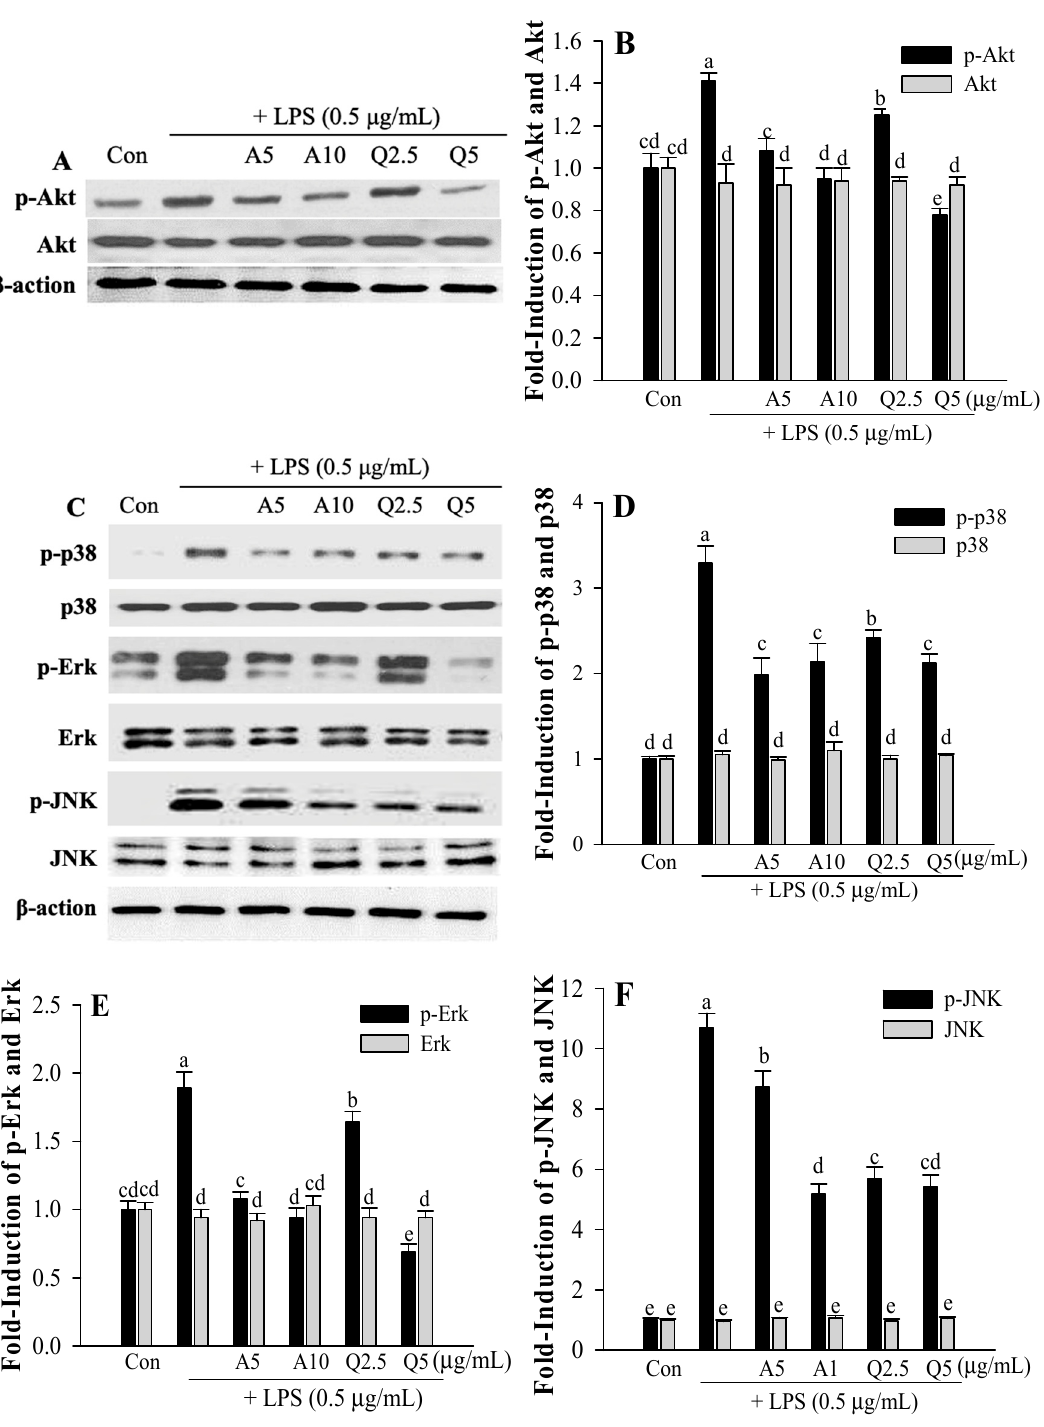
Figure 6. Effect of Ast (or A) and Que (or Q) on LPS-induced phosphorylation of Akt ( A , B ) and MAPKs (p38, Erk, and JNK; ( C – F )) pathways in microglia. Con, control: LPS- and sample-untreated cells; Group LPS: cell treated with LPS only. The density of each protein band was quantified by using SigmaGel software. The values shown are the mean ± SD ( n = 3) and means with different letters (a–e) within a property differ significantly as shown by Duncan’s multiple range test ( p < 0.05). Akt, protein kinase B; Erk, extracellular protein regulated protein kinase; JNK, c-Jun N-terminal kinase; MAPKs, mitogen-activated protein kinases.